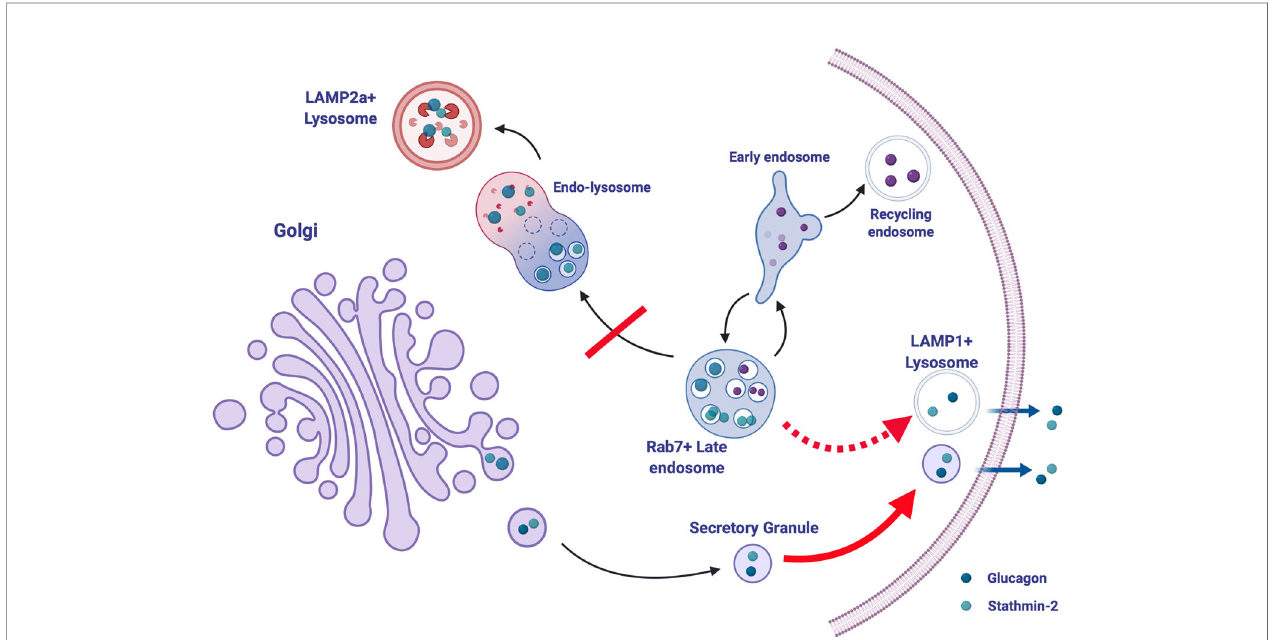
FIGURE 4 | Stathmin-2-mediated lysosomal traf fi cking modulates glucagon secretion. Glucagon (dark blue) and stathmin-2 (light blue) are normally sorted to secretory granules from the Golgi in alpha cells. Stathmin-2 overexpression diverts glucagon-containing secretory granules to lysosomes (black arrows), thus reducing glucagon secretion. In the relative absence of stathmin-2, this regulatory pathway is disrupted; transport of glucagon and stathmin-2 to the LAMP2 + lysosome is inhibited and instead is re-routed to lysosomes (possibly LAMP1 + ) adjacent to the plasma membrane, thus and allowing for excess glucagon secretion (dotted red arrow). Additionally, secretion from secretory granules is also enhanced (solid red arrow). Created with